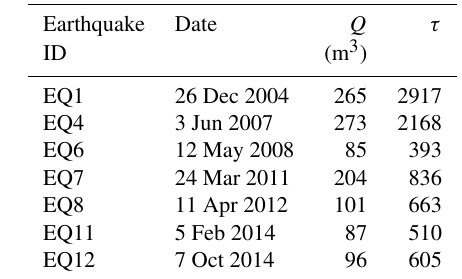
Table 4. Parameters estimated by the data of discharge coseismic response in Dazhai well, western Yunnan Province,